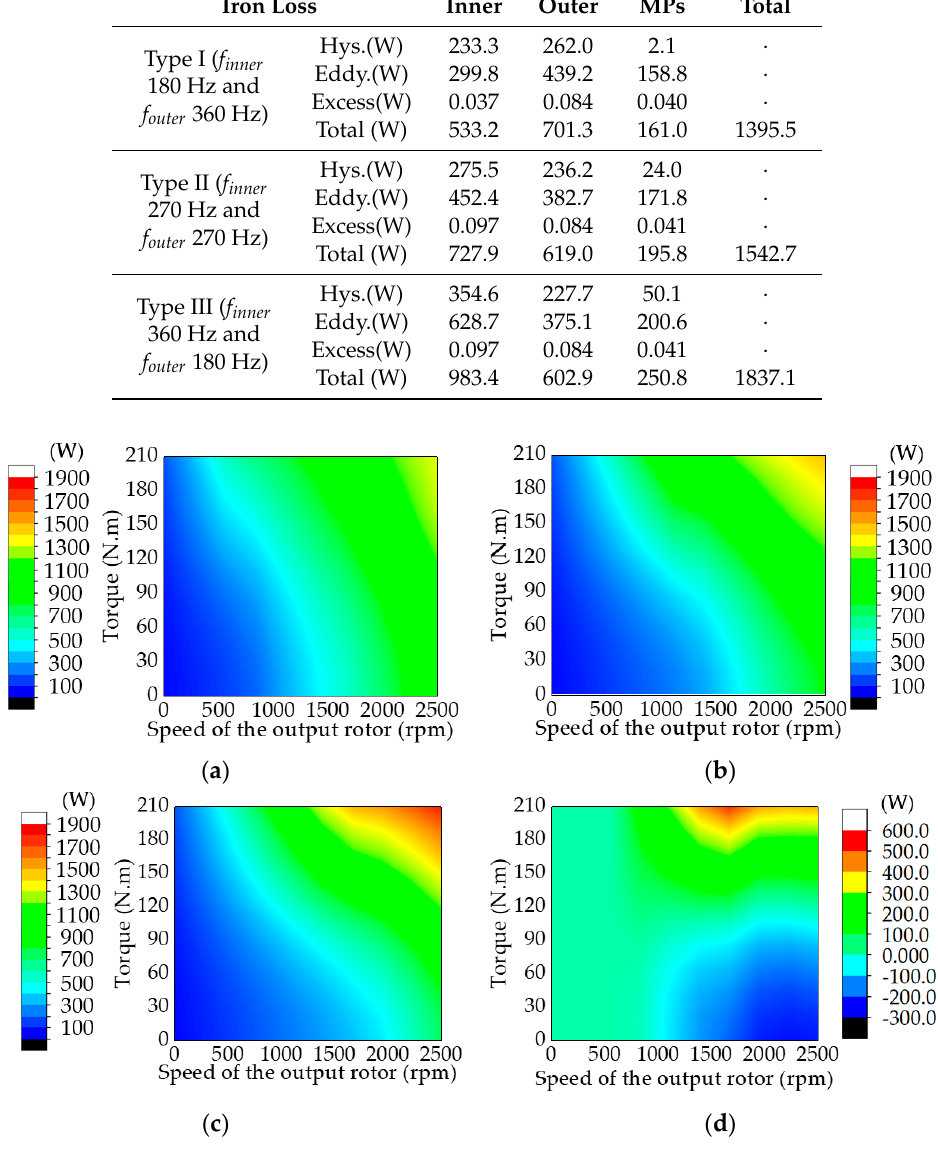
Figure 7. Iron loss map in the constant torque region according to the winding frequency when the amplitude of the inner winding current is adjusted and the outer winding current is fixed at the rated current (168 Arms). ( a ) Type I ( f inner 180 Hz and f outer 360 Hz); ( b ) Type II ( f inner 270 Hz and f outer 270 Hz); ( c ) Type III ( f inner 360 Hz and f outer 180 Hz); ( d ) Difference between Type III and Type I.